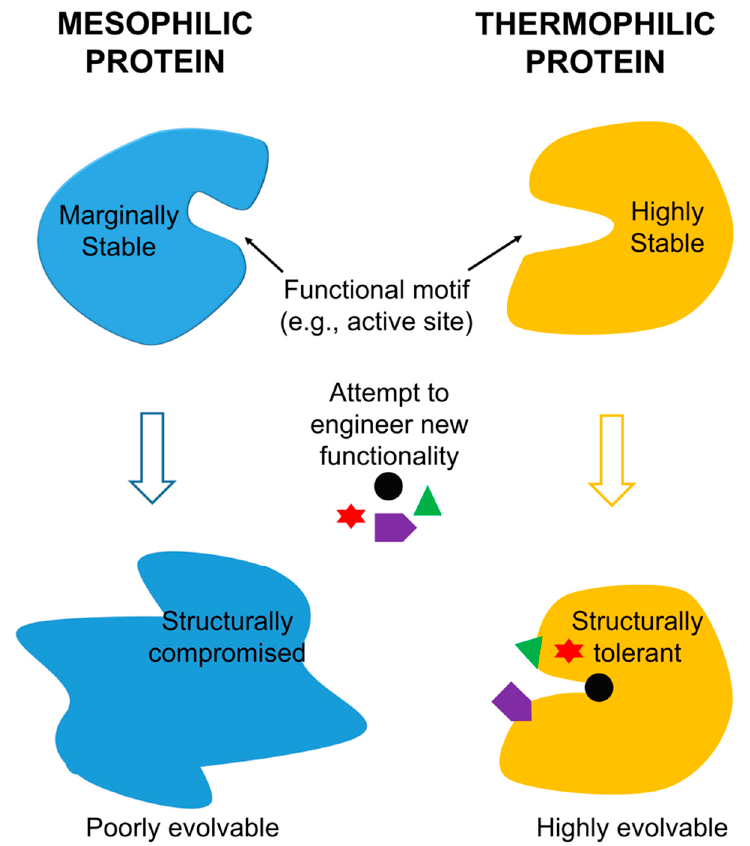
Figure 2. A schematic of facile functional evolution from thermophilic proteins assisted by their high thermostability. Insufficient stability of mesophilic proteins limits their evolvability.